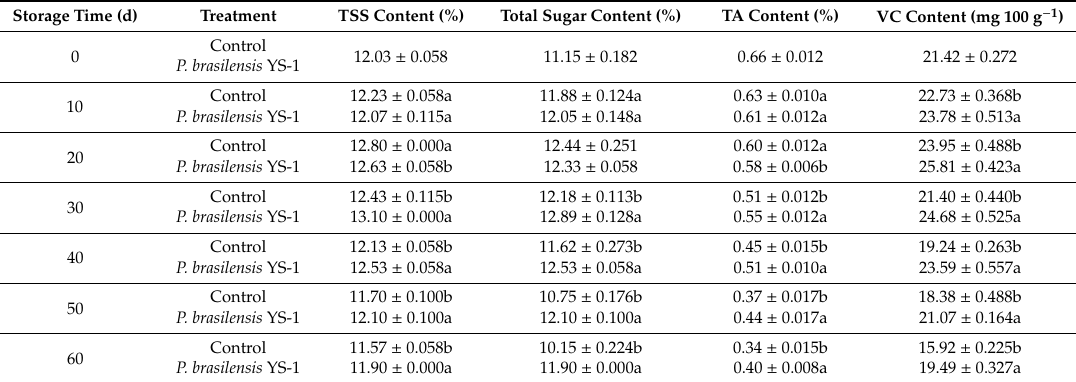
Table 1. Variation in the total soluble solids (TSS), total sugar, titratable acidity (TA), and vitamin C (VC) contents of citrus fruit under cold storage in relation to P. brasilensis YS-1 treatment. Storage Time